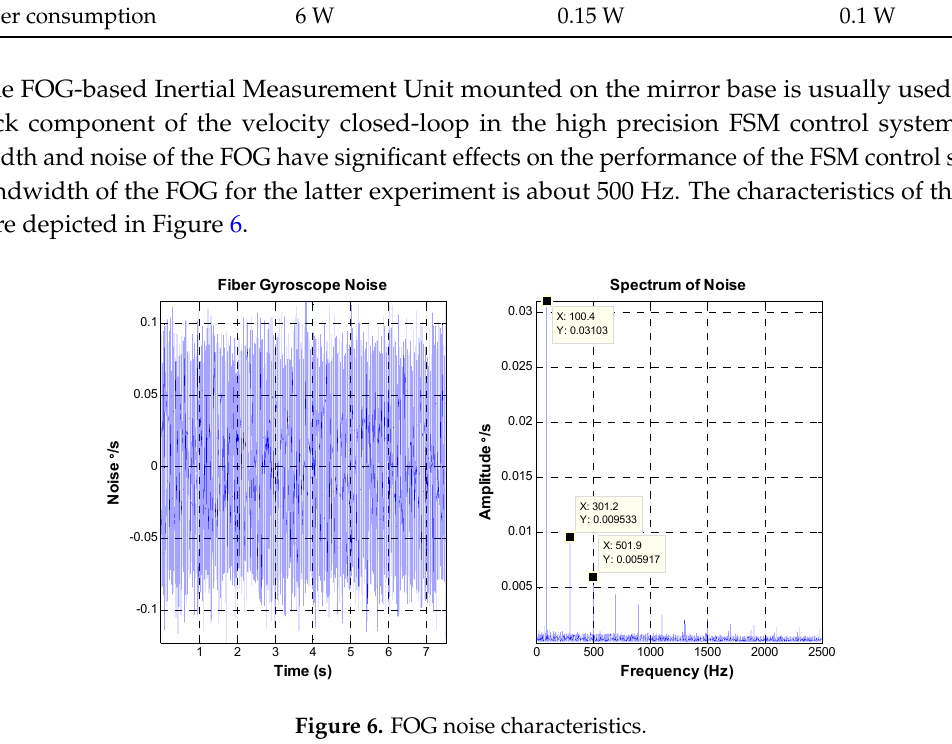
Figure 5. Picture of inertial sensors. Table 1. Comparison of the three types of sensors.